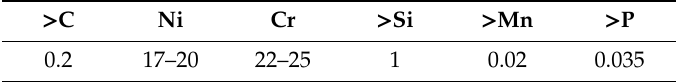
Table 1. Chemical composition (%) of AISI 310S steel (balanced by Fe).